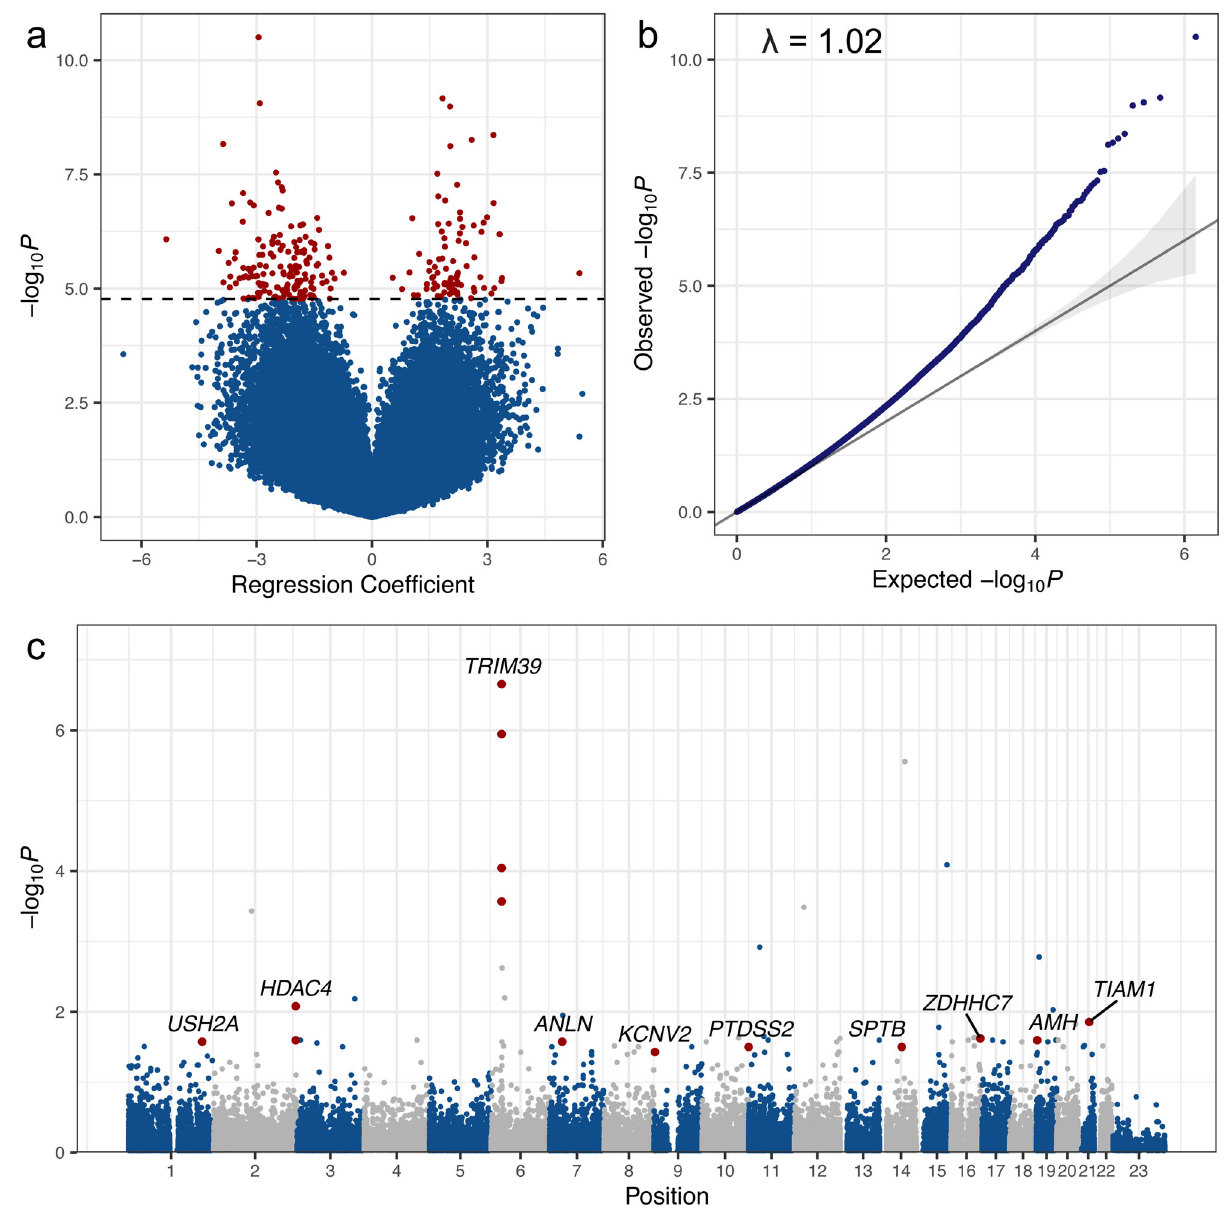
P ).Gray-shadedarearepresents95%con fi denceinterval. c Manhattanplotof − log 10 ( regionally adjusted P values showing the genomic location of the 10 signi fi cant differentially methylated regions (DMRs) identi fi ed in regional analysis. Signi fi cant regions (shown in red) were de fi ned as Š idák-corrected P <0.05 identi fi ed using comb-p. The most signi fi cant DMR, associated with TRIM39-RPP21 , includes a 454bpregionencompassing9probesonchromosome6(noteonlyfoursigni fi cant probeslocatedwithinthisregionareshownduetooverlapping P values).Asecond 167bp region on chromosome 19 including four probes associated with AMH overlaps with a CoRSIV site. Source data are provided as a Source data fi